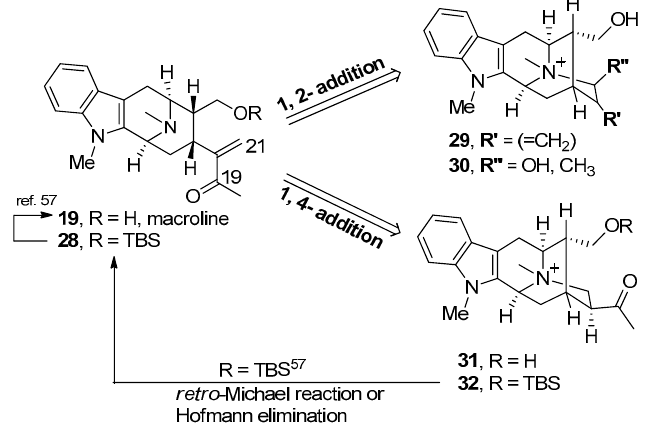
Figure 4. Interconversion of macroline 19 and sarpagine 25 .